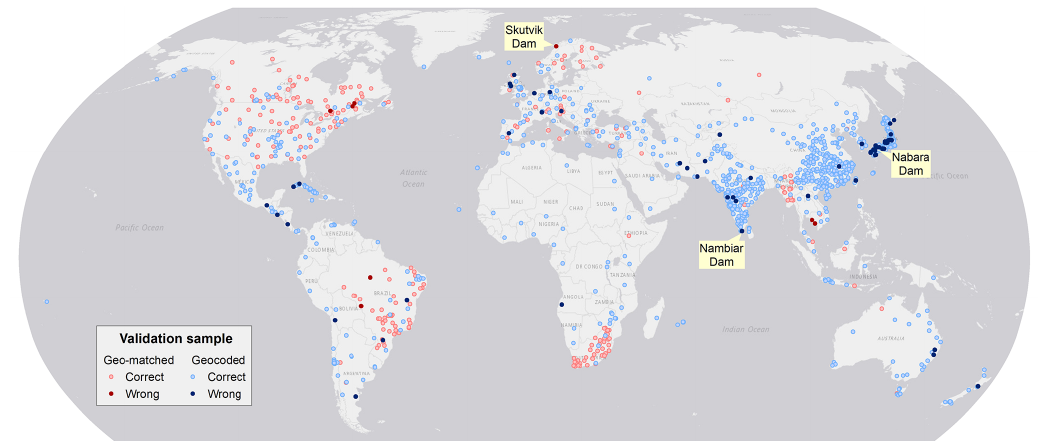
Figure 8. Validation sample and results for GeoDAR v1.0. The validation sample consists of 1413 georeferenced ICOLD dams, including 260 dams from geo-matching and 1153 dams from geocoding. The dam points labeled as georeferencing errors are displayed at their corrected locations if possible. See Table 4 for detailed validation statistics. Table 5. Summative comparisons among the ICOLD WRD, GRanD, and GeoDAR. Statistics ICOLD